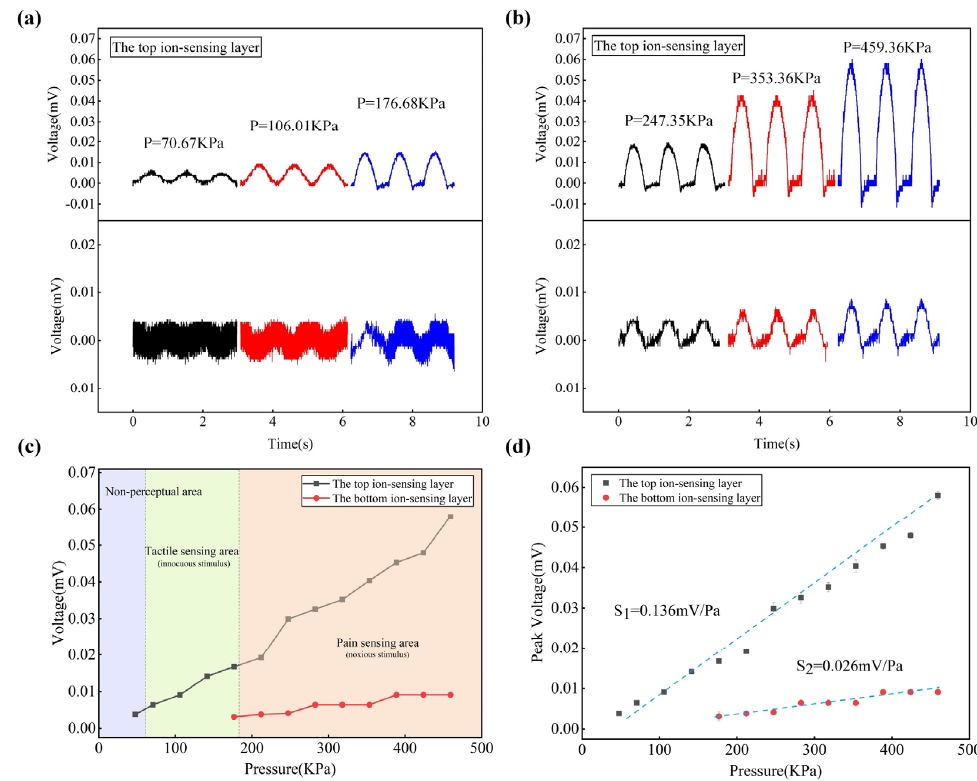
Figure 6. Experimental results of the bio − inspired artificial receptor. ( a , b ) Real − time waveform of the output voltage under different normal force amplitudes with a frequency of 1 Hz. ( c ) The voltage response with the increase of pressure shows different sensing modes in different pressure ranges. ( d ) Sensitivities of the bio − inspired artificial receptor during the pressure from 0 to 500